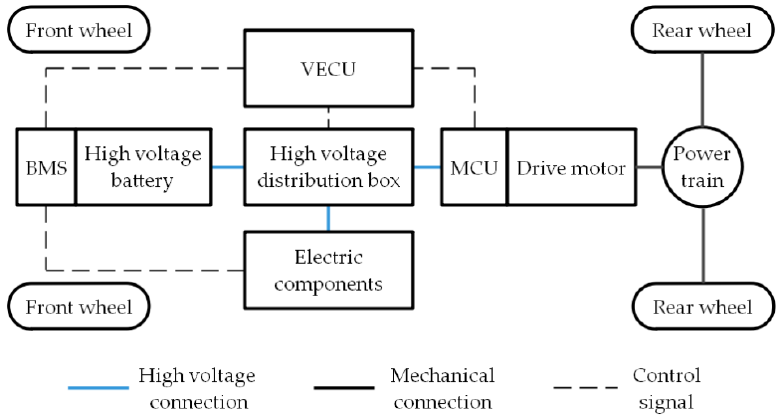
Figure 1. The schematic of the EV configuration. Table 1. Vehicle and component parameters in the studied vehicle.